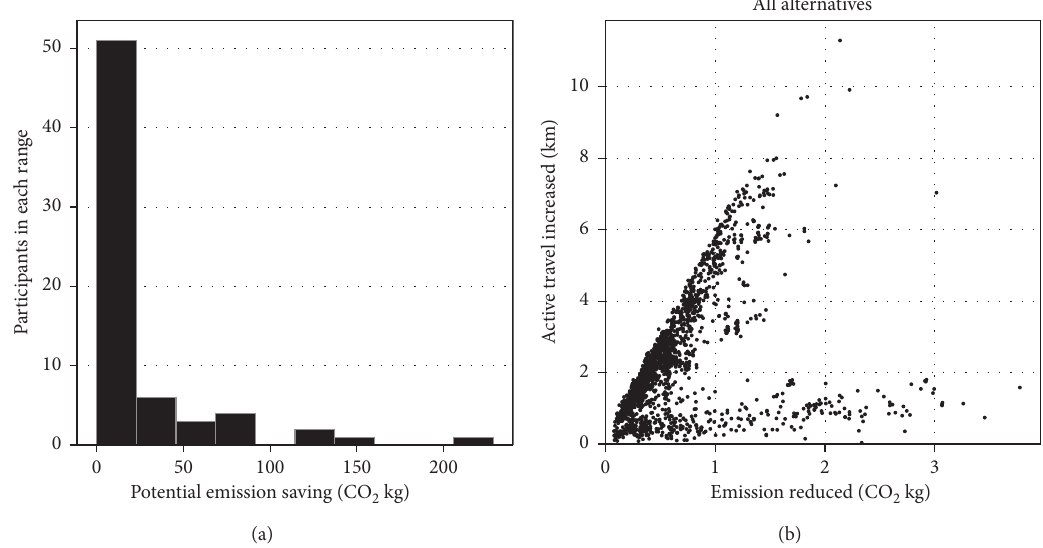
Figure 20: (a) Distribution of total emission savings per active participant. (b) Potential emission savings versus active travel distance increase, where each point represents one door-to-door trip of an active participant.